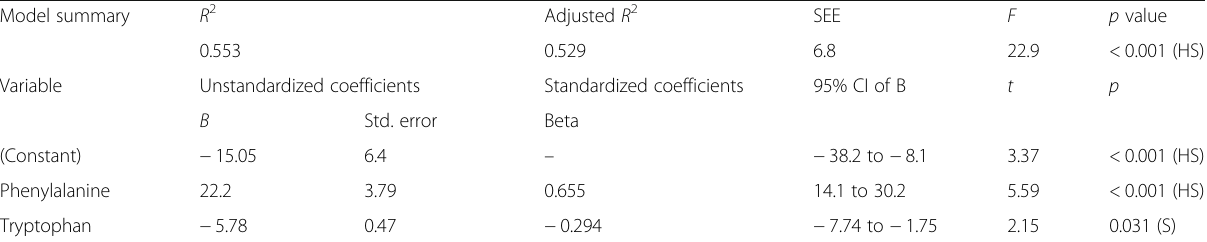
Table 5 Multiple linear regression for the predictors of HDRS scale of depression among the treated group Model